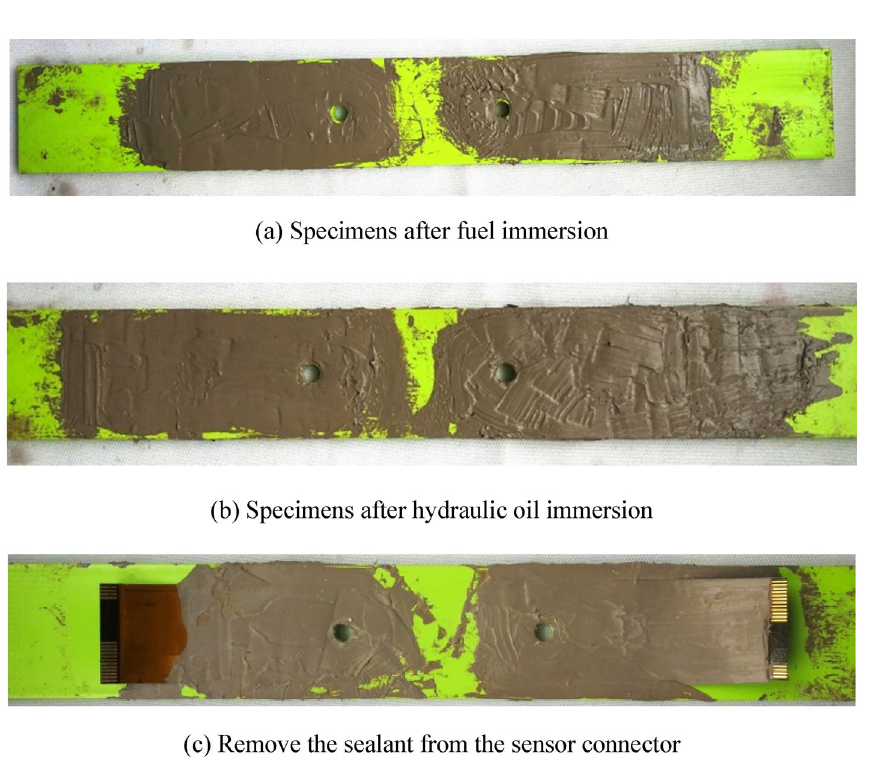
Figure 18. Specimen after fluid immersion experiment.